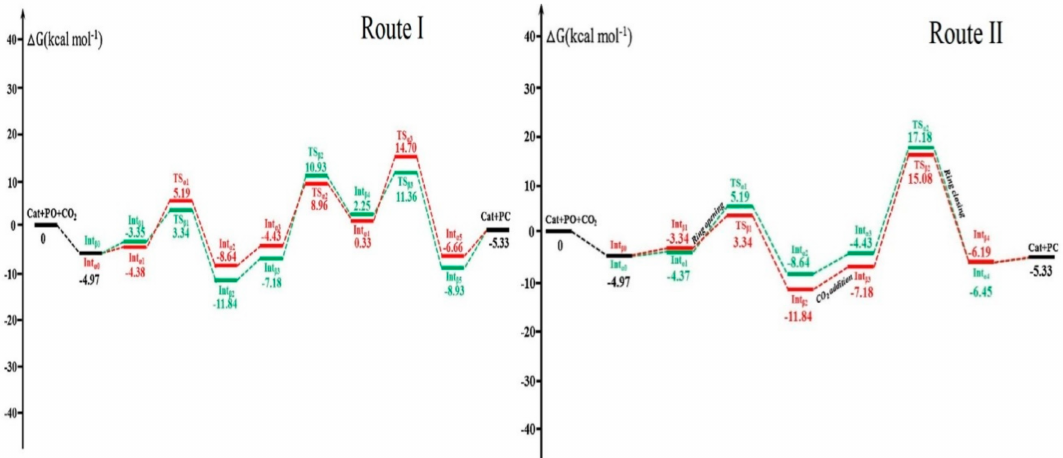
Figure 17. Gibbs free energy surface profiles in CO 2 cycloaddition of PO catalyzed by MIL-101(Cr)/TBABr. Reprinted with permission from Ref. [67]. Copyright 2018